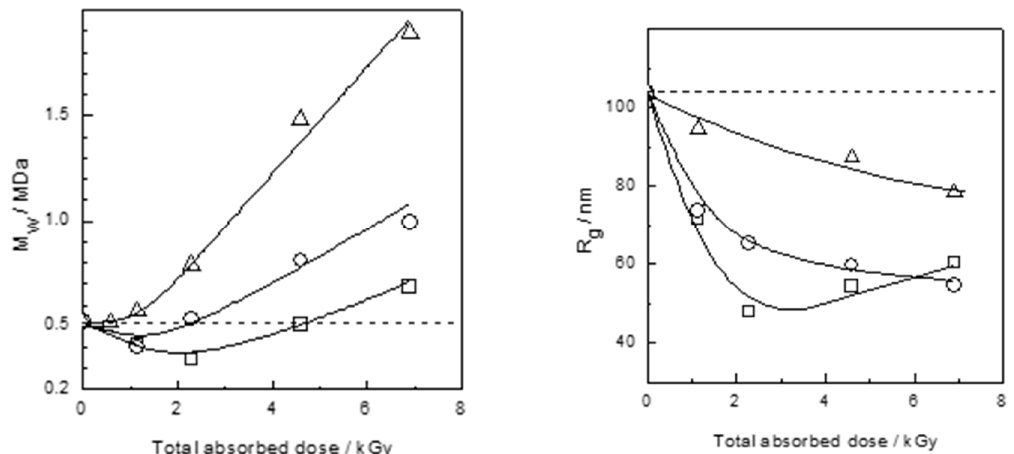
Figure 23. Radiation synthesis of poly(acrylic acid)—PAA nanogels. Weight-average molecular weight ( M w —left panel) and radius of gyration (R g —right panel) of PAA macromolecules in the course of nanogel synthesis as a function of total absorbed dose (1.15 kGy corresponds to a single pulse) for samples of various PAA concentrations: ◻ —10 mM, ○ —17.5 mM, —25 mM, irradiated in Ar-saturated aqueous solutions, pH 2. Radii of gyration measured at 25.0 °C in aqueous 0.5 M NaClO 4 , pH 10. Reprinted with permission from [240]. Copyright (2003) American Chemical Society.